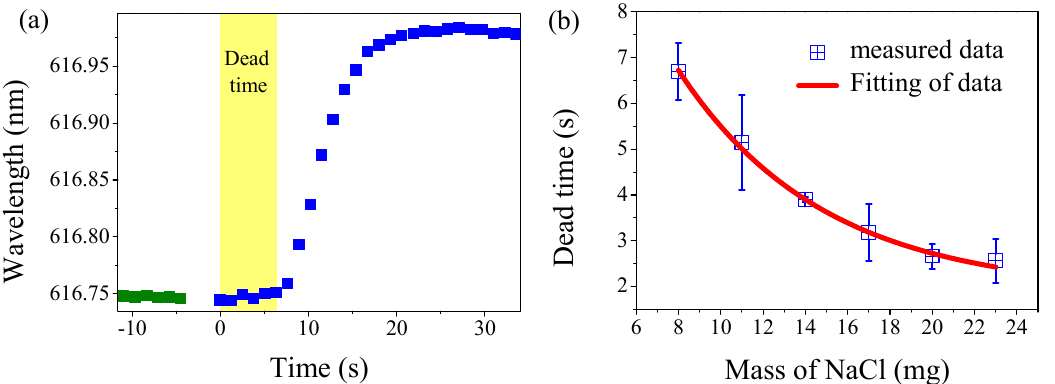
Figure 7. ( a ) Response of lasing wavelength recorded separately before (green dots) and after (blue dots) adding the salt (8 mg) into the water. The yellow region represents the dissolution process (dead time). ( b ) Dead time as function of the mass of the salt.